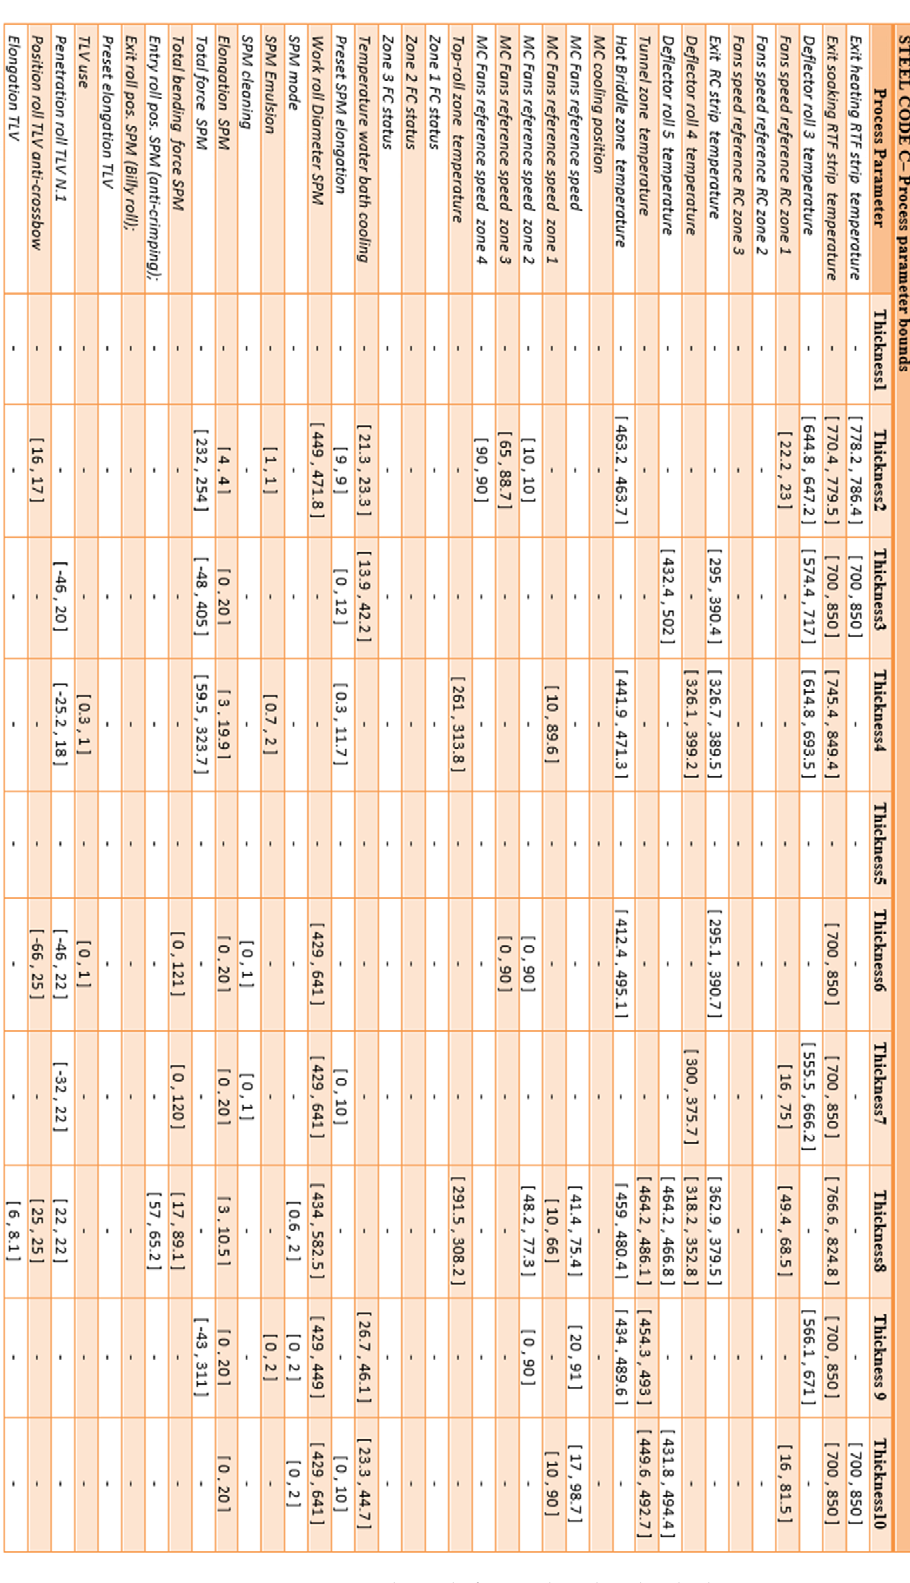
Figure A3. Process parameter bounds for Steel Code C by thickness range.